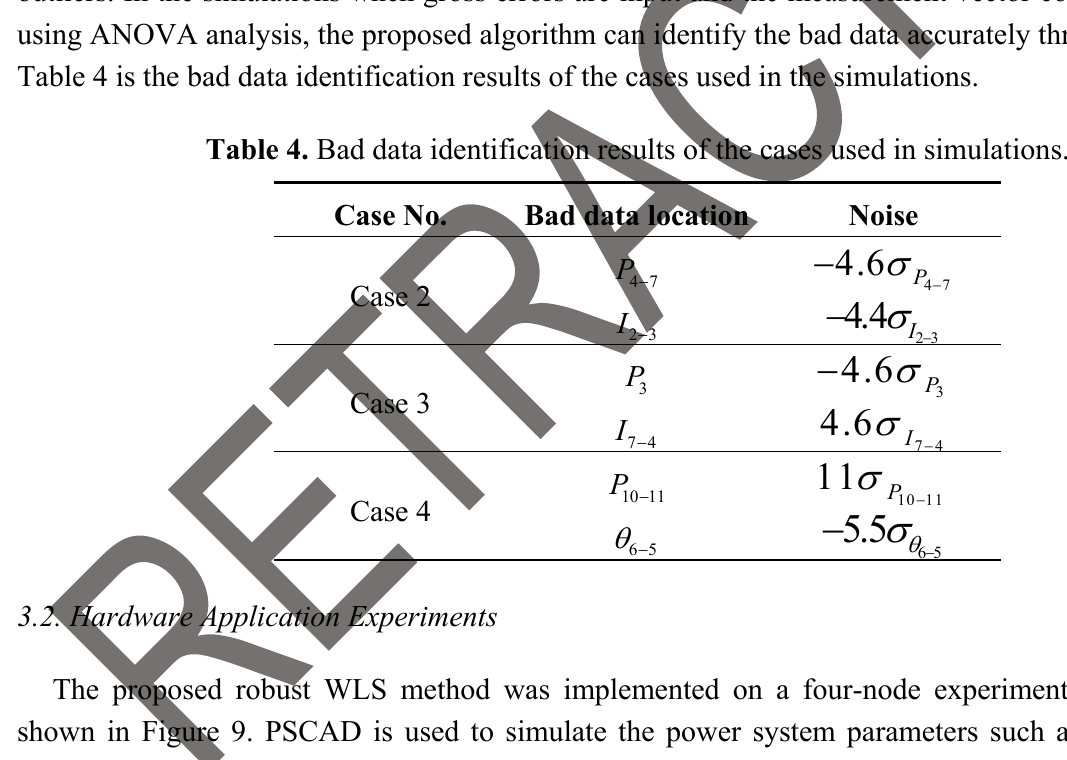
Figure 8. Bus voltage angle estimate error of simulation cases.